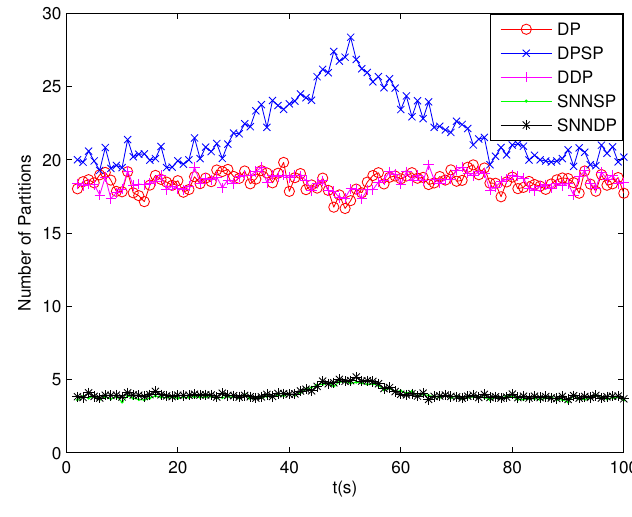
Figure 9. Number of